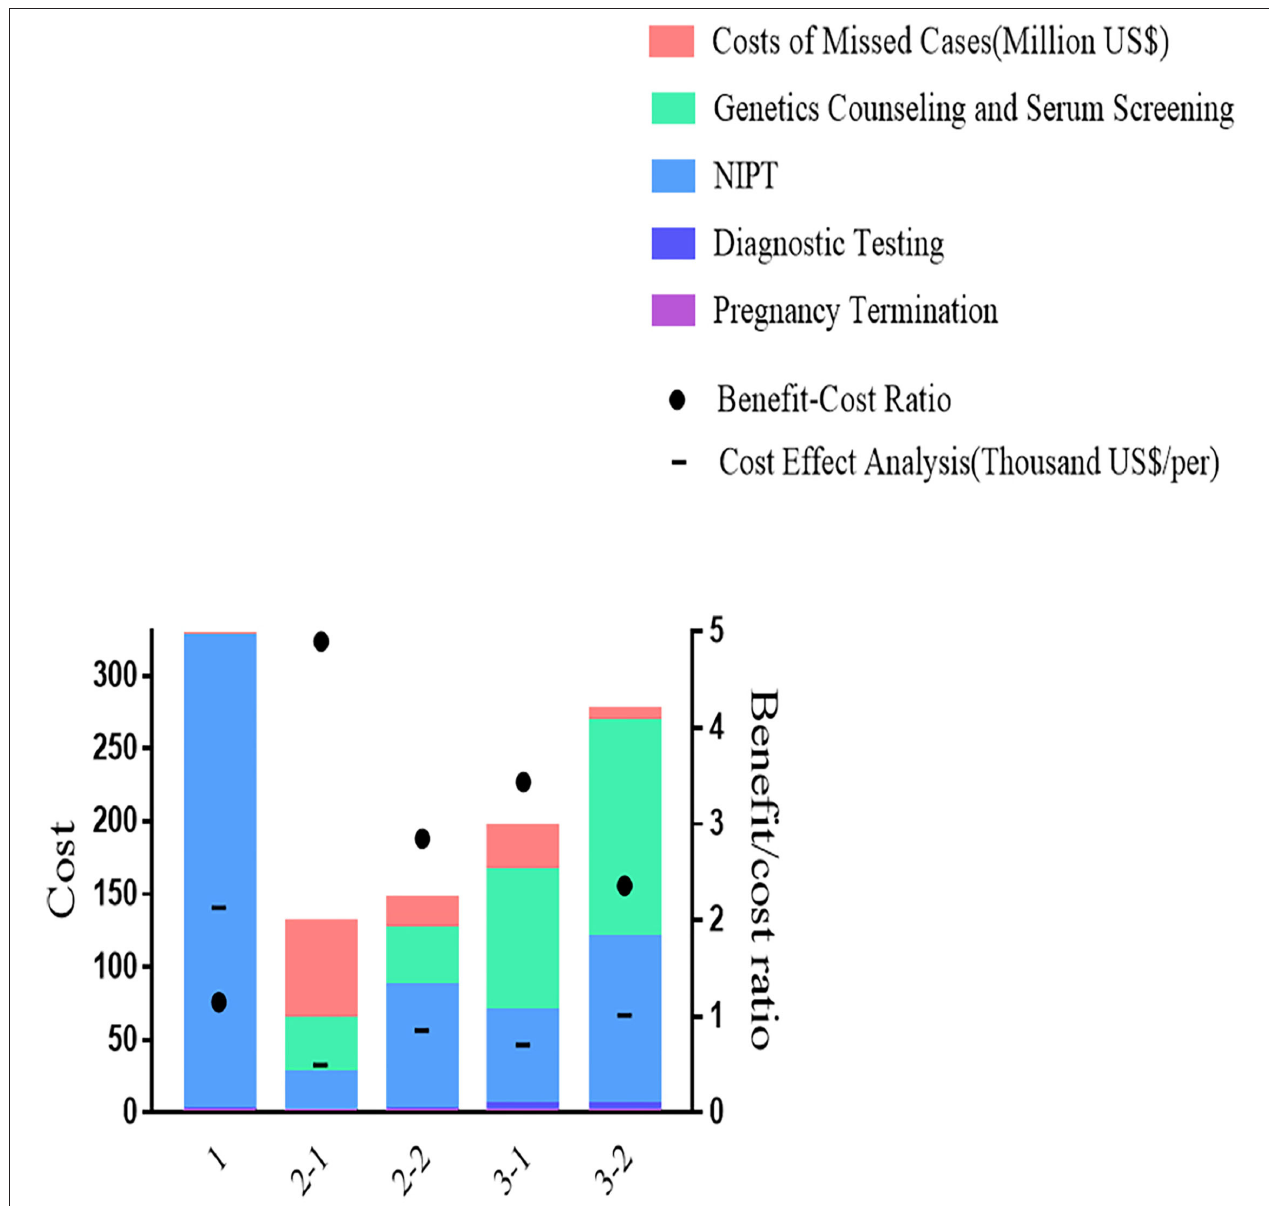
FIGURE 4 | Total costs, cost-effect, and cost-benefit analysis of different